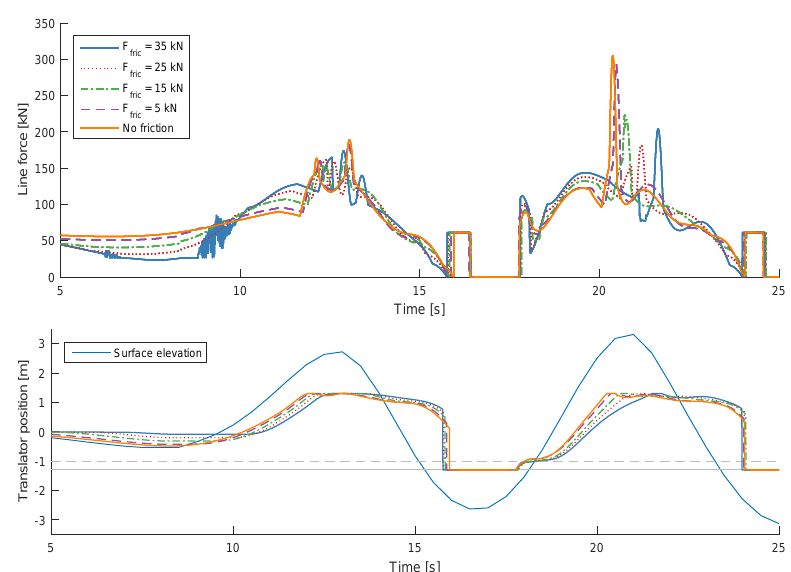
Figure 9. This is a zoom of Figure 8. The WEC is impacted by a high regular wave. The solid horizontal line marks the bottom of the generator, and the dashed horizontal line marks the lower endstop spring.